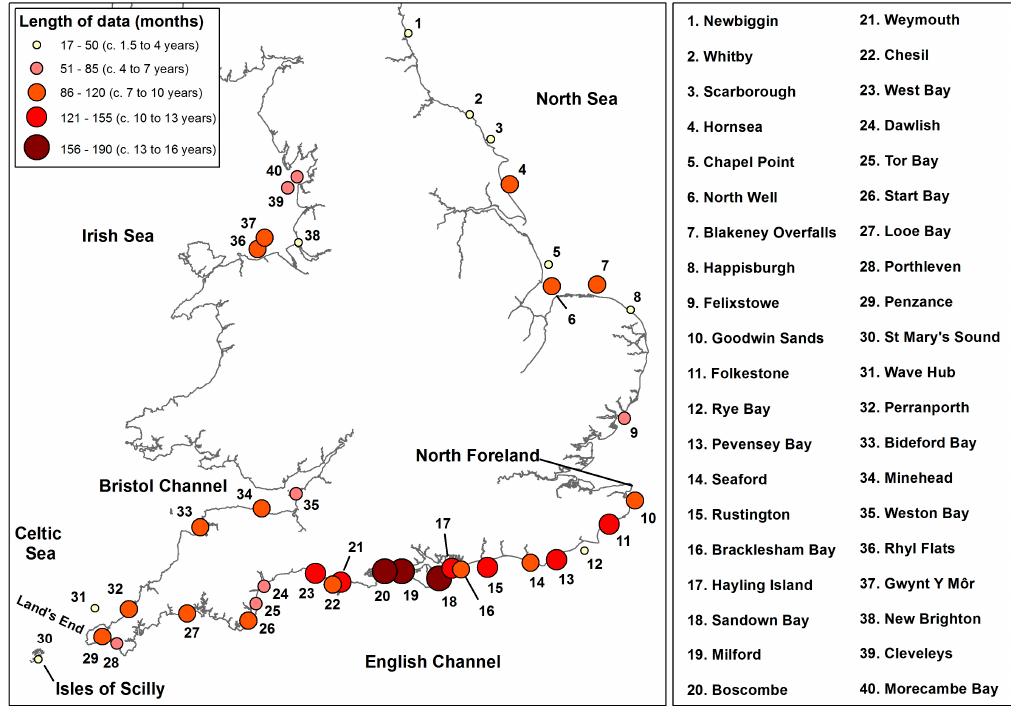
Figure 1. Location and deployment length of the wave buoys (with 90% monthly data